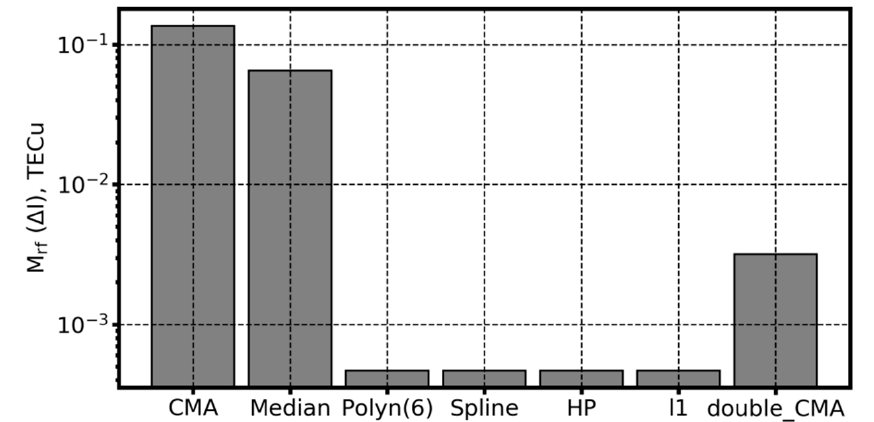
Figure 4. The mean bias error, M RF for various detrending techniques. Y-axis has a logarithmic scale.